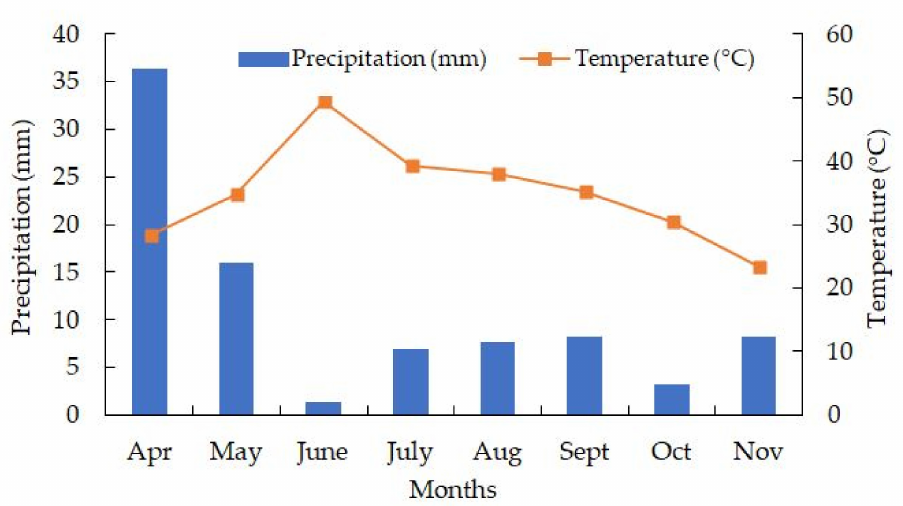
Figure 1. Monthly average precipitation and temperature of the research area. Source: https: // www.weather-atlas.com / en / afghanistan /